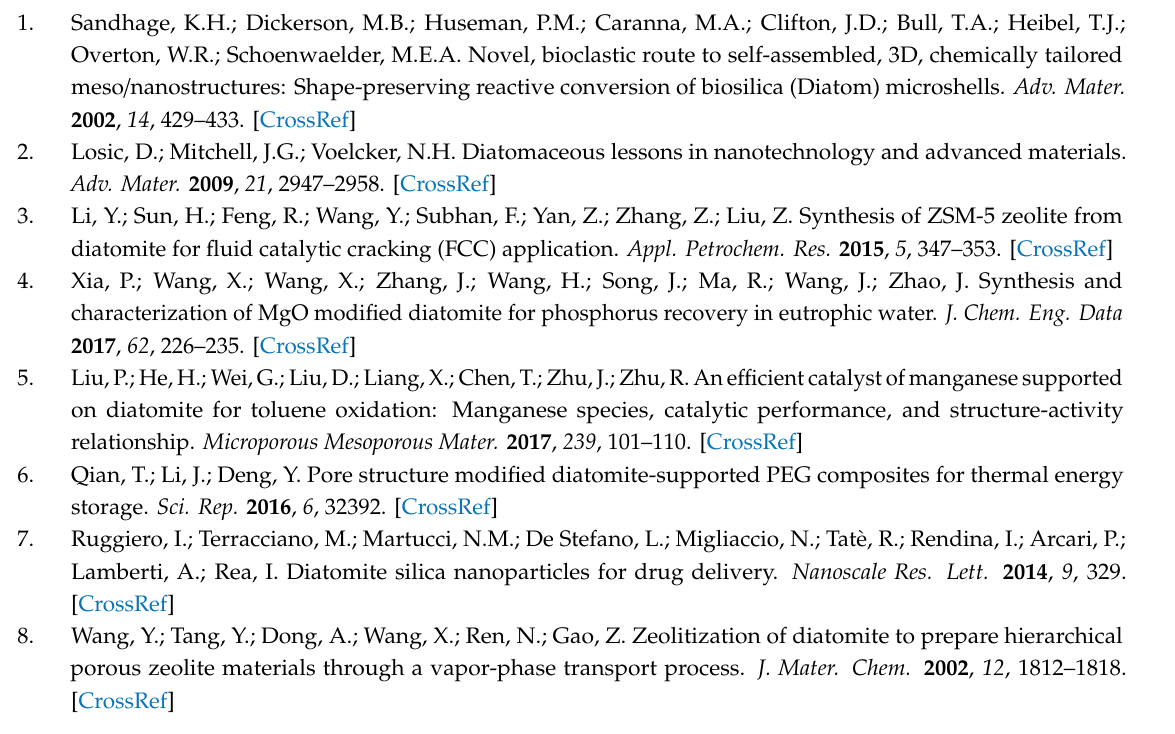
Figure S1: XRD Di ff ractograms of diatomite-based material after a hydrothermal treatment of 8 h in the presence of di ff erent amounts of CTAB 0 wt. %, 3 wt. %, and 10 wt. %., Figure S2: XRD Di ff ractogram of diatomite-based material after a hydrothermal treatment of 8 h at 160 ◦ C in the presence of CTAB or